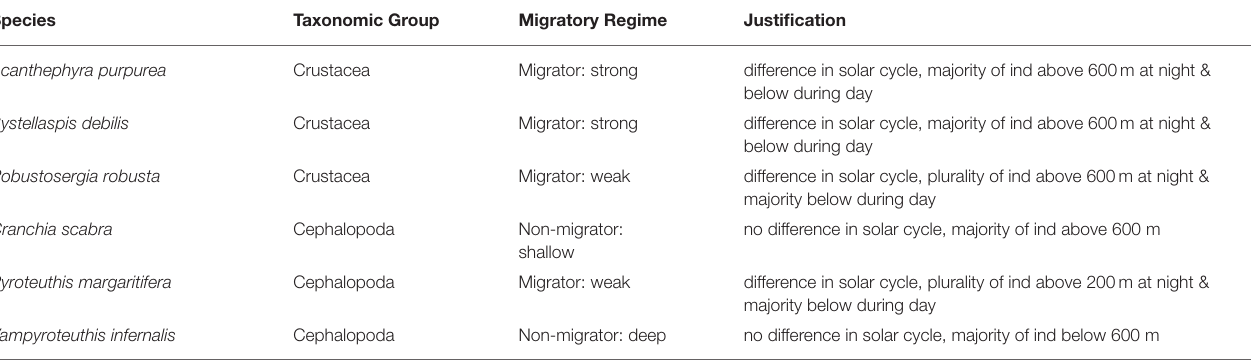
TABLE 2 | Characterization of each species by migratory regime based on biophysical oceanographic modeling (BOM) (export ceases for migrators below 600m and non-migrators below 500m) and recorded diel vertical migratory behavior (difference in depth-discrete abundance by solar cycle and proportion of individuals above or below the BOM export depths).